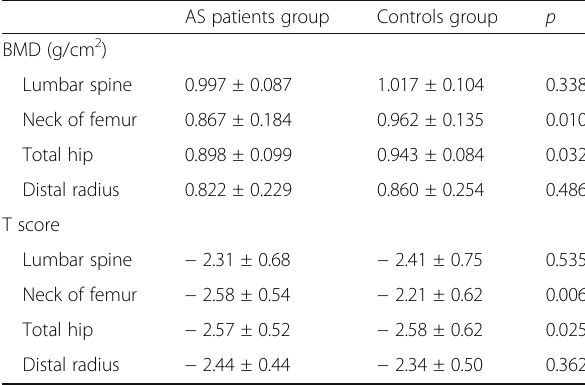
Table 2 Comparison of DXA findings between AS patients and